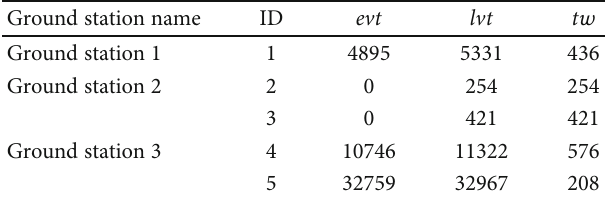
Table 2: Example of satellite ground station time